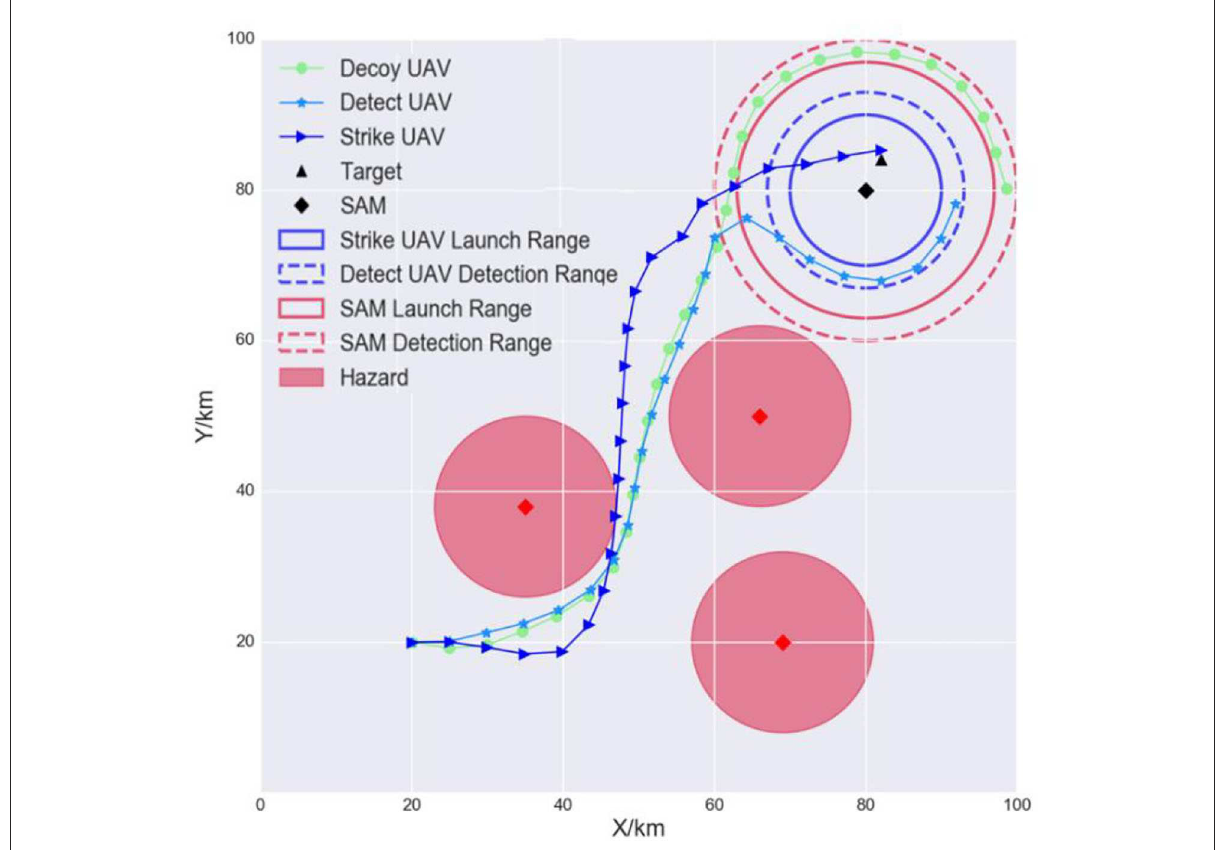
FIGURE9 Effectiveness during testing.